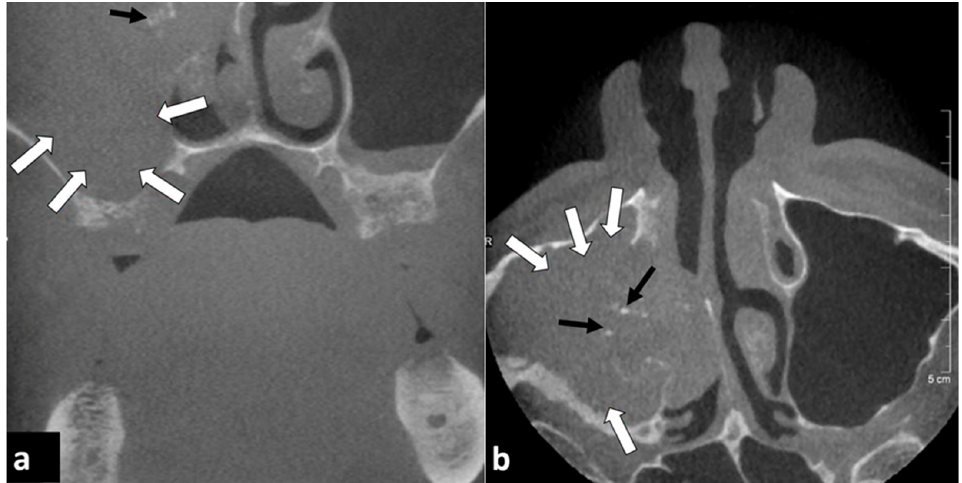
Figure 2. Eighty-three year old male patient. CBCT was performed for implant planning. ( a ) Coronal and ( b ) axial reconstructions showed a maxillary sinusitis on the right side with mucosal swelling (white arrows) bulging into the nasal cavity. Sparse calcifications (black arrows) within the mucosal swelling may indicate a fungal infection.